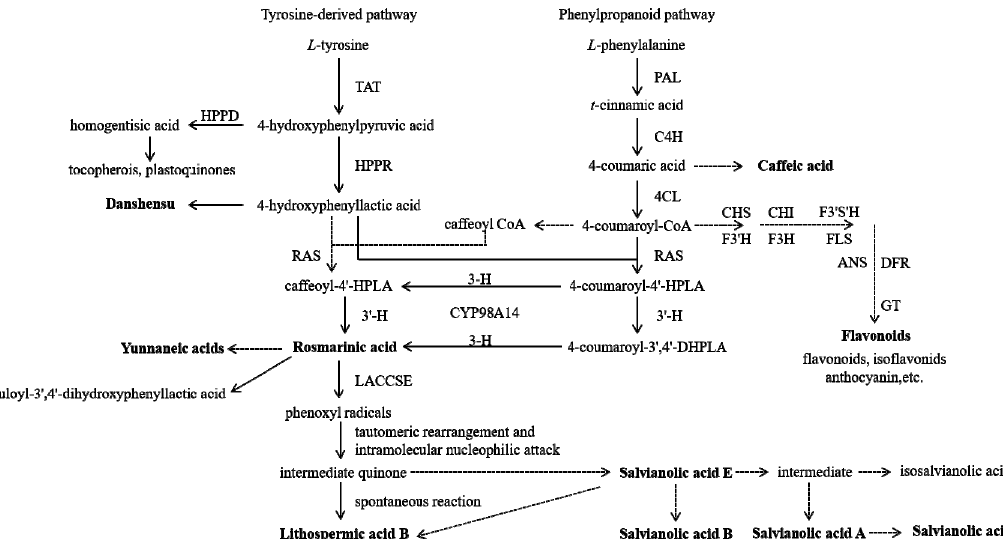
Figure 1. The biosynthetic pathway of phenolic acids in Salvia species. TAT: tyrosine aminotransferase;